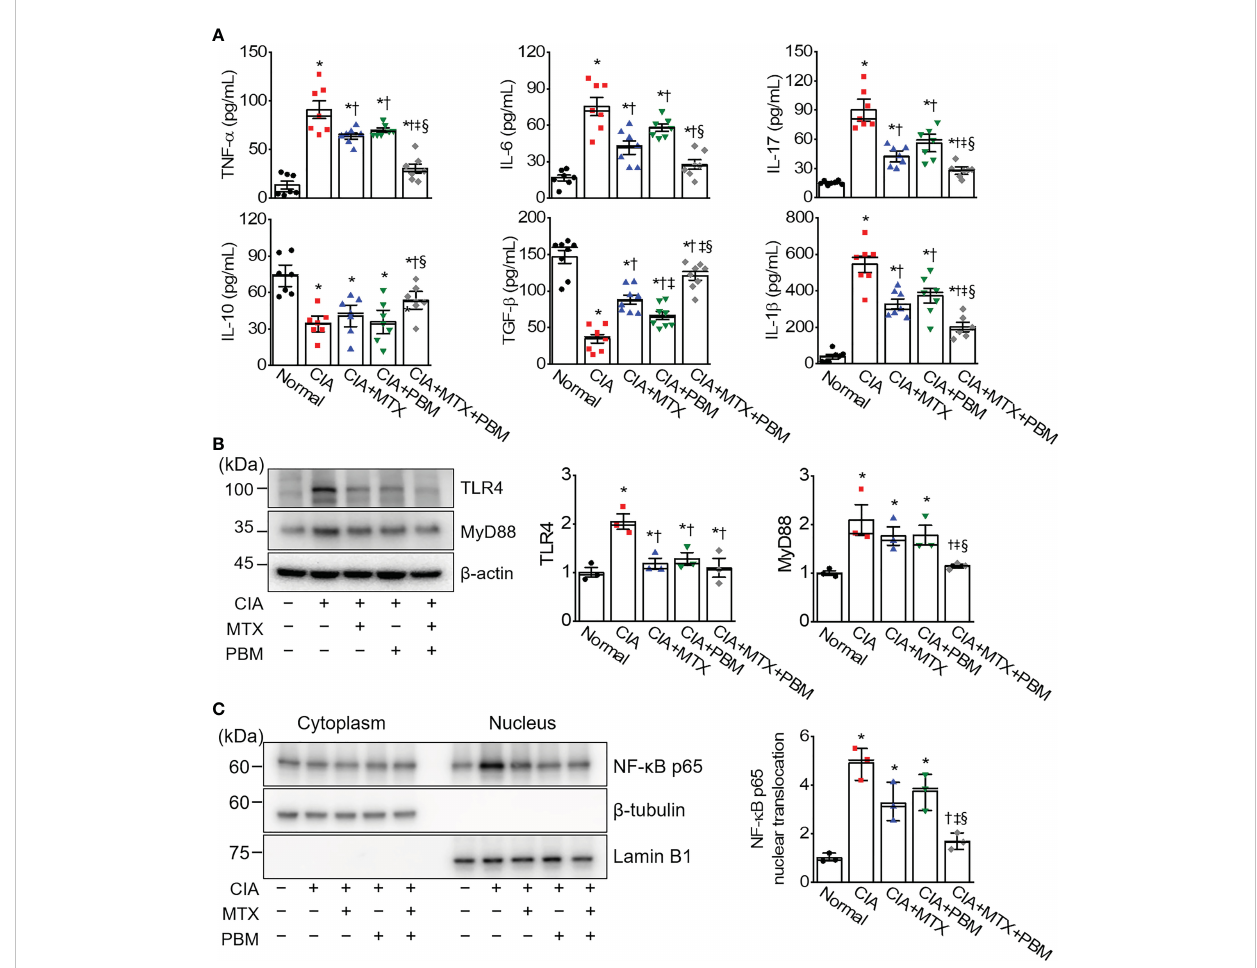
FIGURE 4 PBM reduces TLR4/NF- k B-mediated in fl ammation in CIA mice. (A) Measurement of TNF- a , IL-1 b , IL-6, IL-17, IL-10, and TGF- b in serum ( n = 7). (B) Expression of TLR4 and MyD88 in the ankle joints tissue lysates ( n = 3). (C) Detection of NF- k B p65 in cytoplasmic and nuclear fractions. Ankle joints tissue lysates were fractionated into nucleus and cytoplasm components ( n = 3). Nucleus fraction was con fi rmed by expression of lamin B1, a nuclear structural protein, and the absence of expression of b -tubulin. An aliquot of cell lysate was analyzed by immunoblotting. Data are shown as mean ± SE. * p < 0.05, compared to Normal. † p < 0.05, compared to CIA. ‡ p < 0.05, compared to CIA+MTX. § p < 0.05, compared to